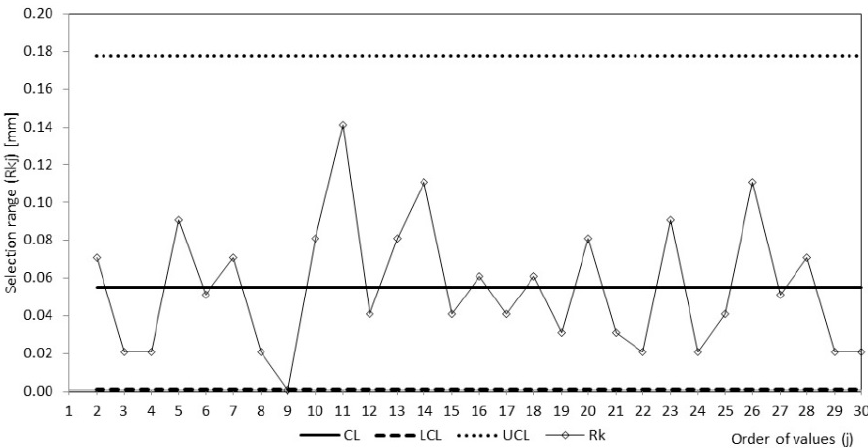
Figure 21. Shewhart control chart for sliding margins for the length parameter, third day.